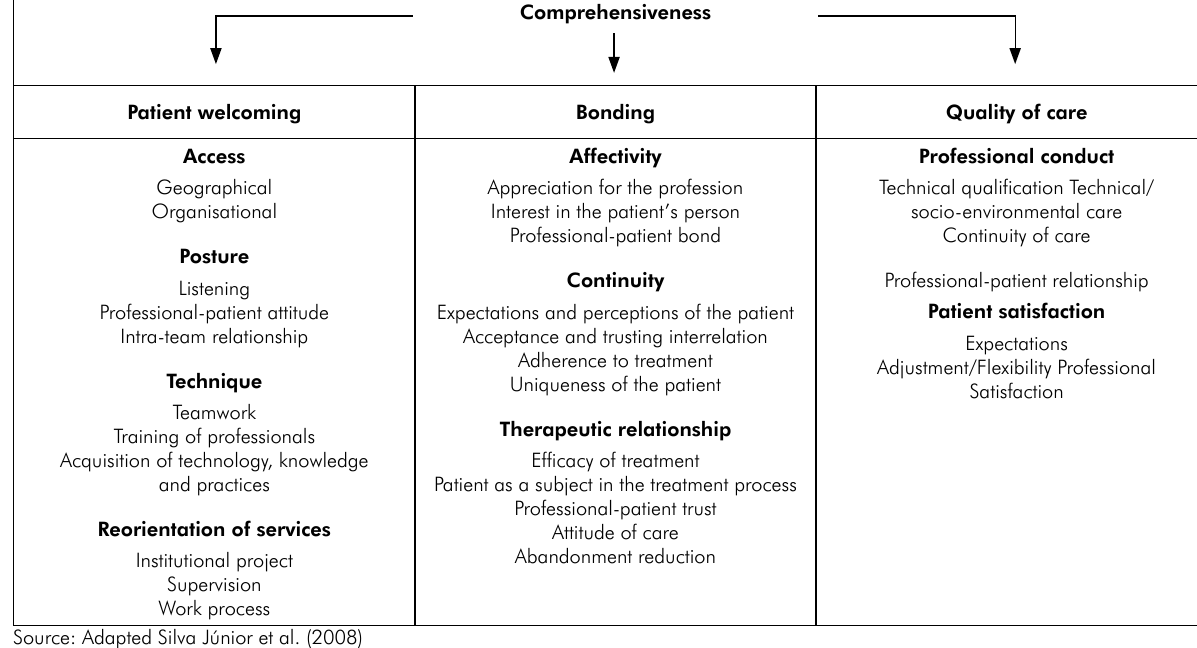
Figure 1. Domains and aspects related to comprehensiveness to be addressed in the assessment of oral health in Primary Health